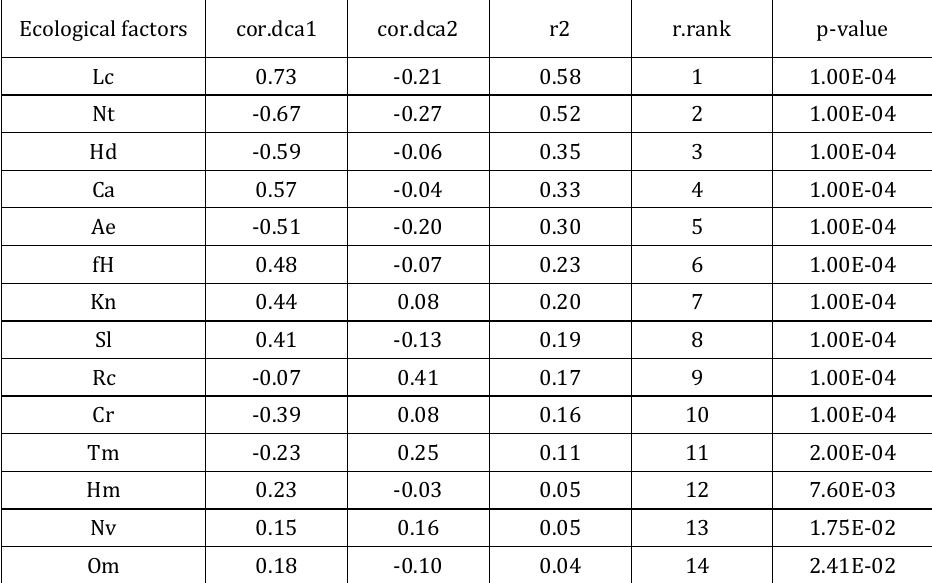
Table 2. Assessment of the correlation between ordination axes and ecological factors Ecological factors cor.dca1 cor.dca2 r2 r.rank p-value